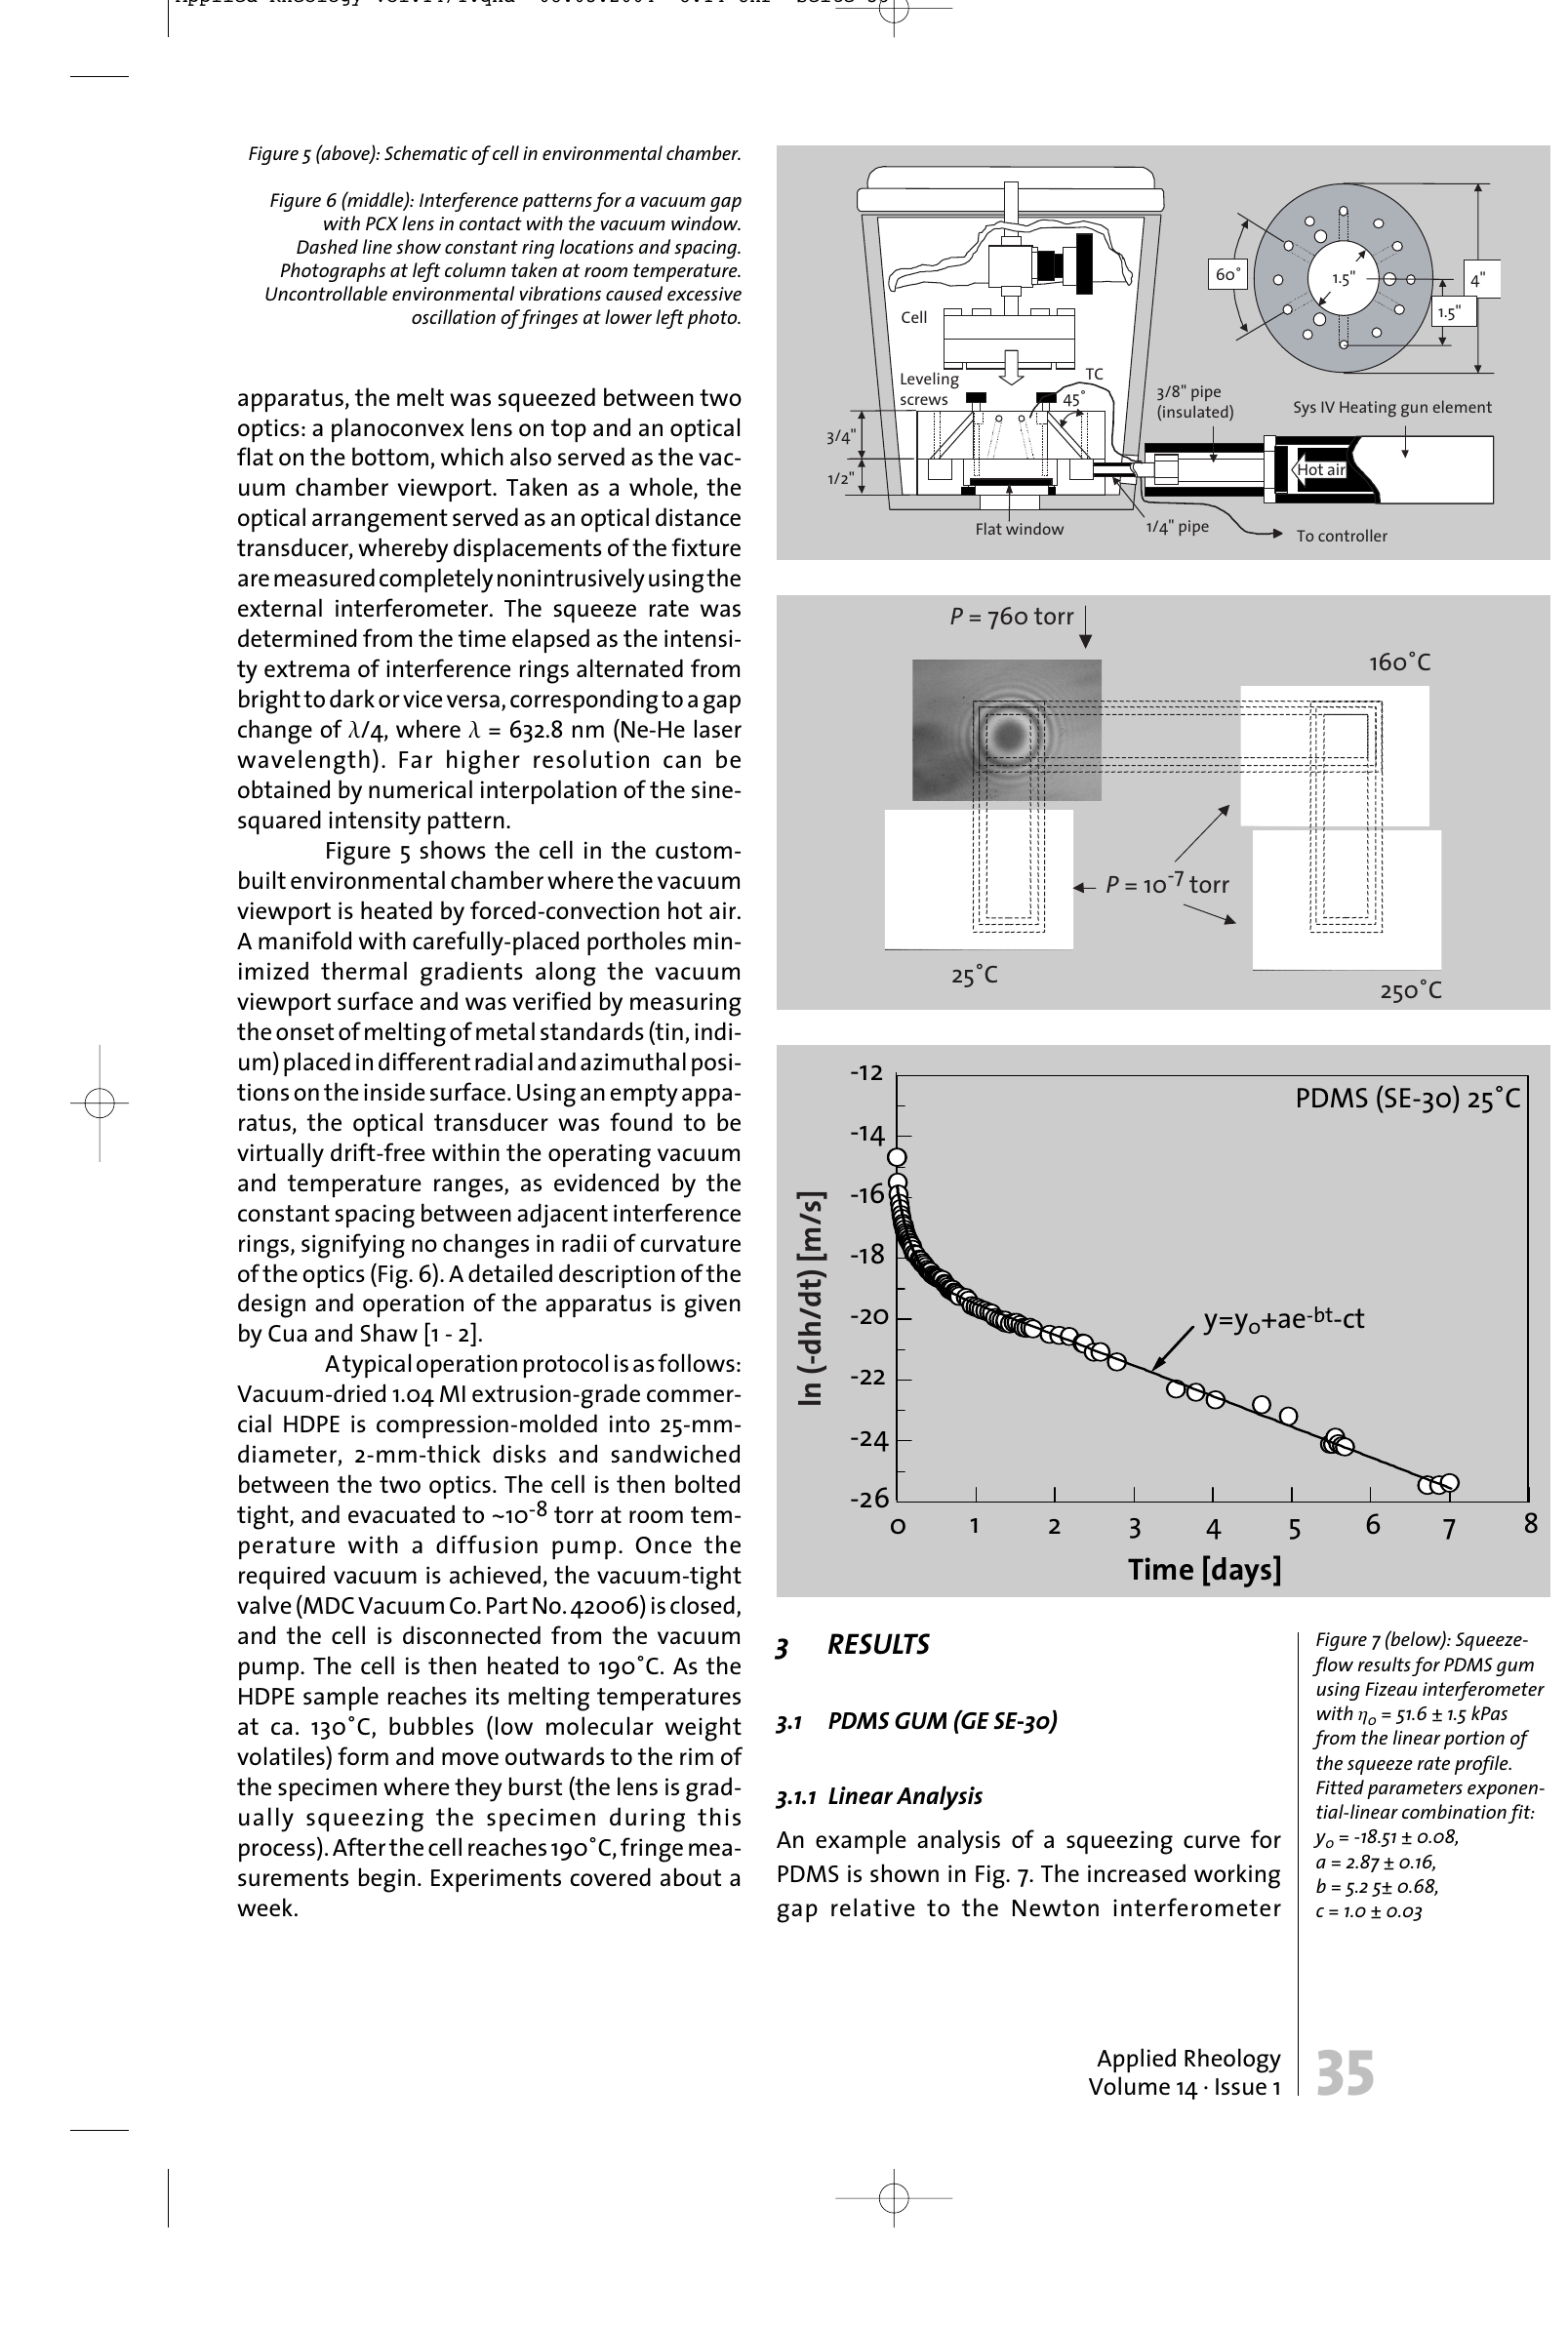
Figure 7 (below): Squeeze- flow results for PDMS gum using Fizeau interferometer with h 0 = 51.6 ± 1.5 kPas from the linear portion of the squeeze rate profile. Fitted parameters exponen- tial-linear combination fit: